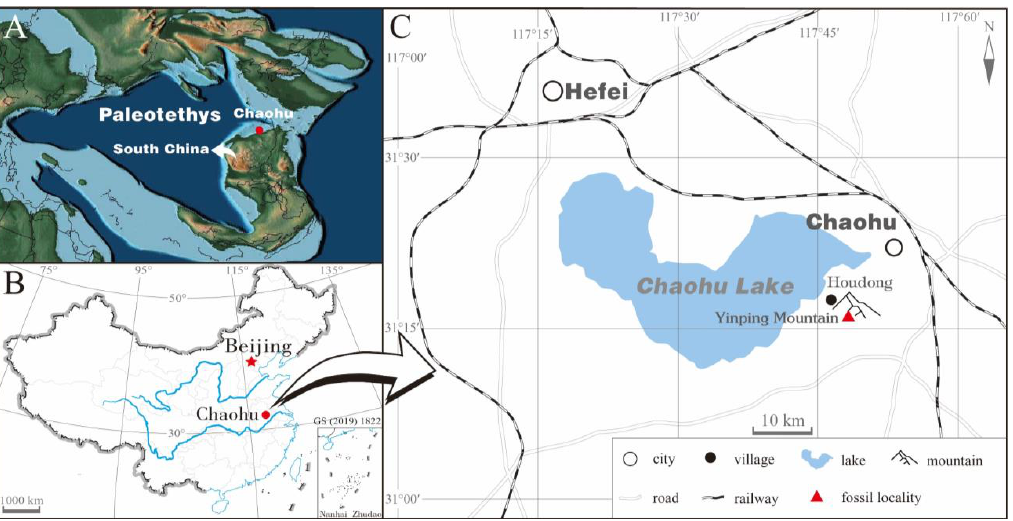
Figure 1. ( A ) Paleomap of the late Capitania, showing the South China Block, base map from Scotese [51]; ( B ) Geographical map of China; ( C ) Geographical map showing the fossil locality.